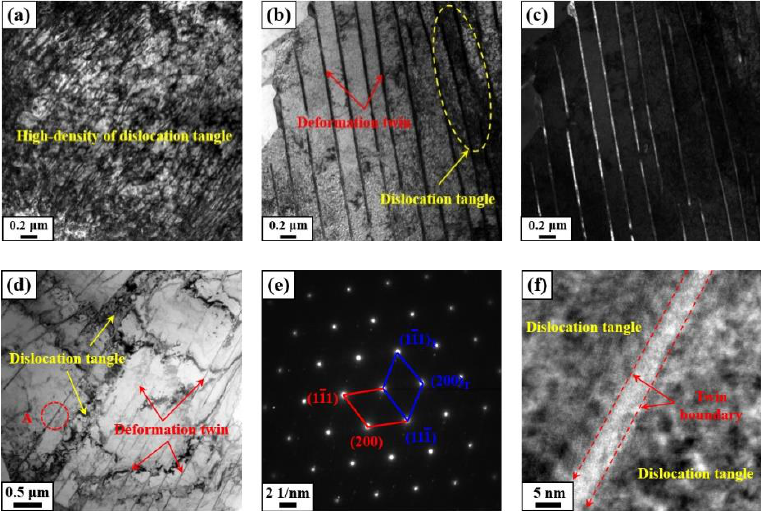
Figure 7. Microstructural TEM observation on the extreme surface treated by LSP. ( a ) High-density of dislocation tangle, ( b , c ) TEM bright-field image of deformation twin and its corresponding dark-field image, ( d ) Image of the interaction between deformation twin and dislocation, ( e , f ) SAED pattern and high-resolution TEM images on deformation twins in area A marked in ( d ).